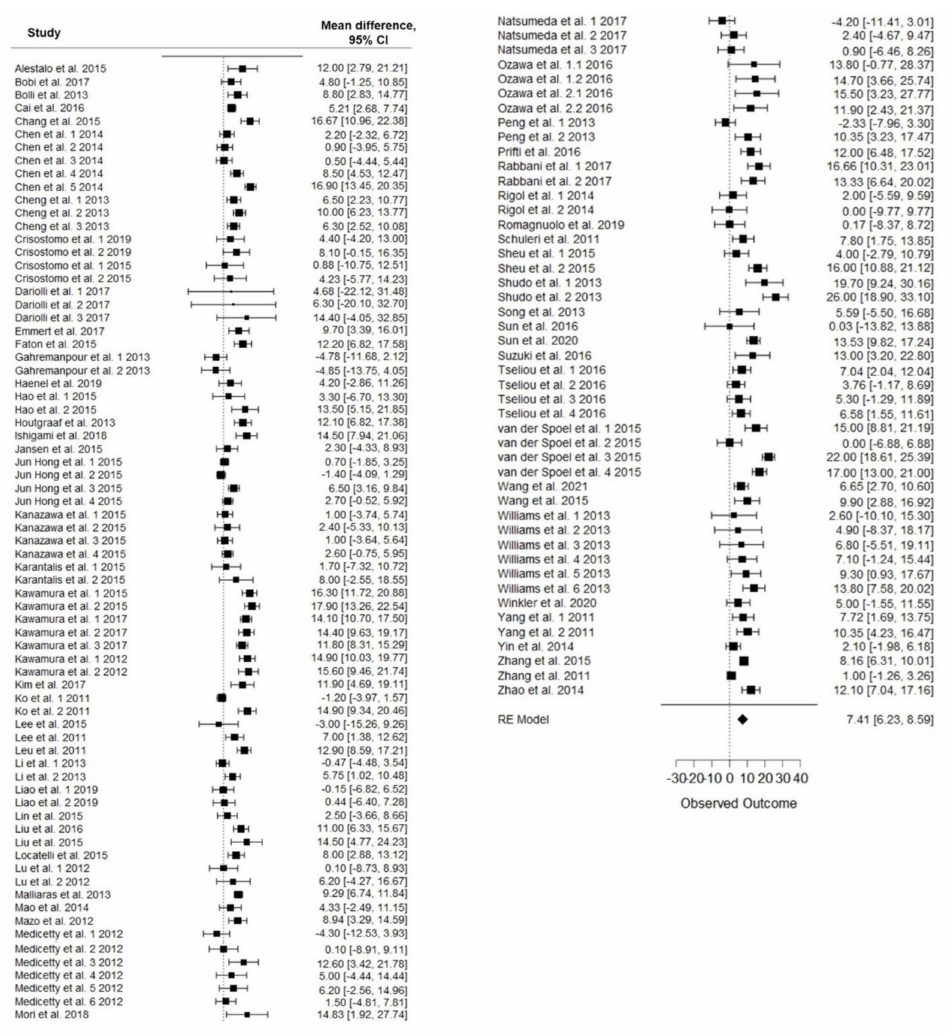
Figure 2. Forest plot showing the effect of stem-cell therapy on LVEF improvement compared with controls. Note: 95% CI, 95% confidence